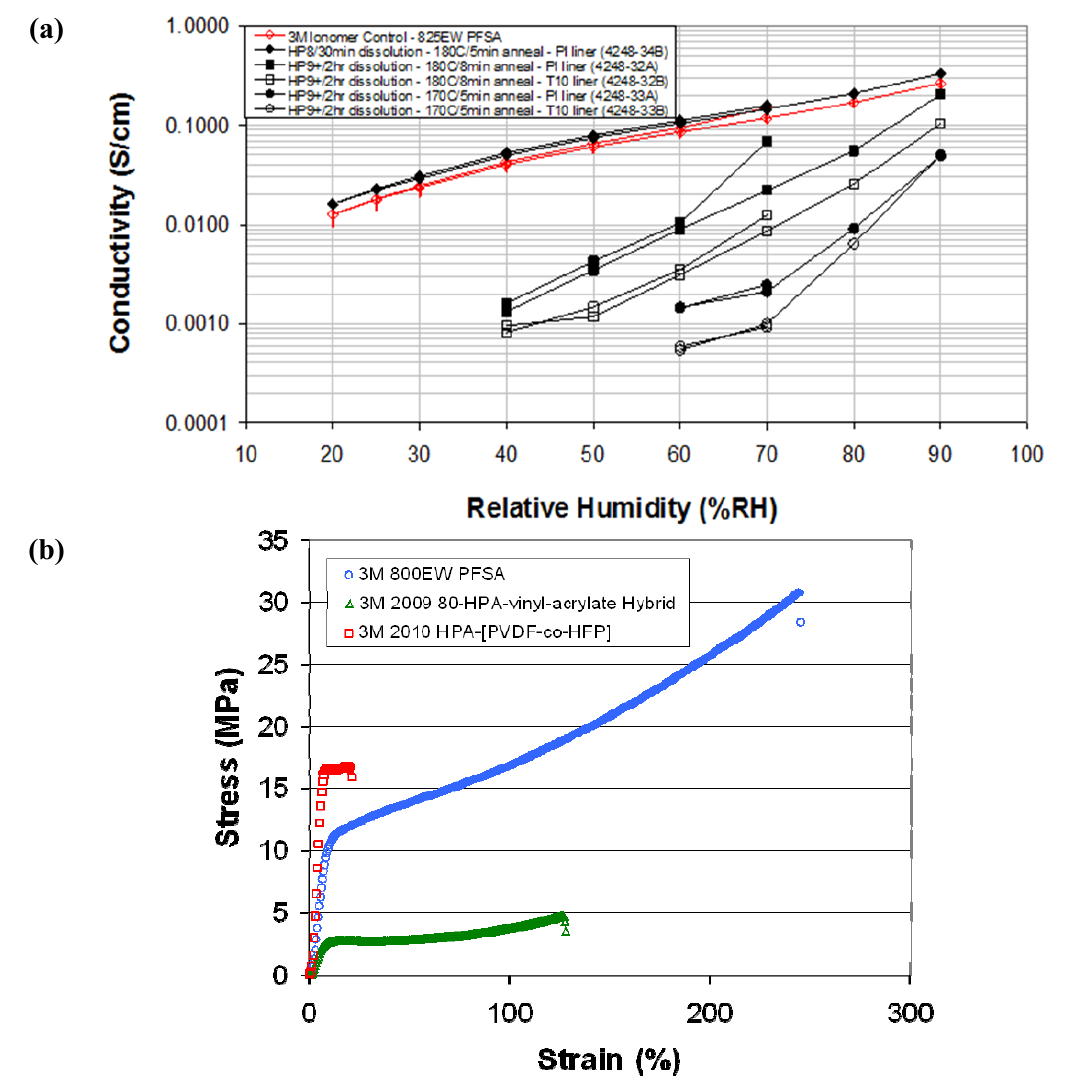
Figure 6. Colorado School of Mines HPA membrane. ( a ) Conductivity data for the HPA functionalized Dyneon™ polymer; ( b ) stress strain curves comparing the HPA